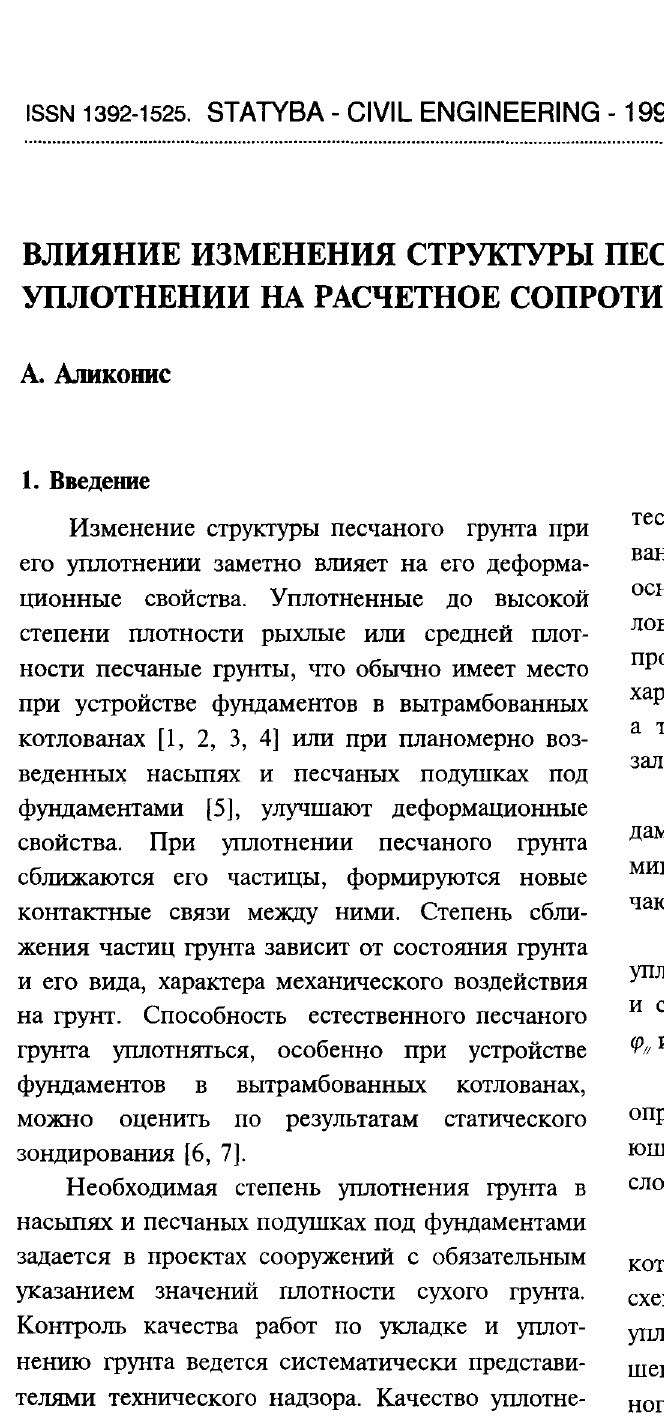
BJIHHHHE U:3MEHEHHH CTPYKTYPbl IIECliAHOfO fPYHTA IIPH